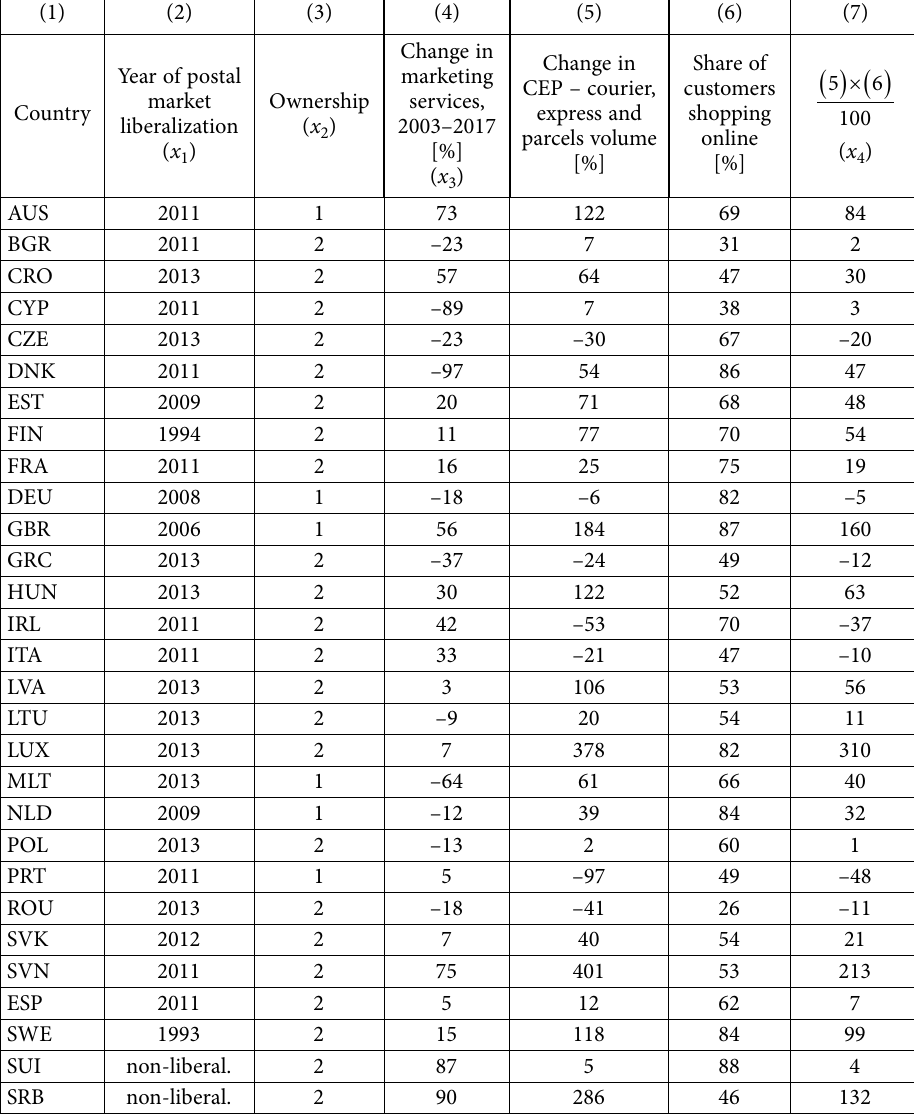
Table 6. Input data for the calculation of determinants of efficiency change (source: Calculated by the authors based on data from Universal Postal Union (2019), WIK (2012) and Ecommerce Europe (2019))